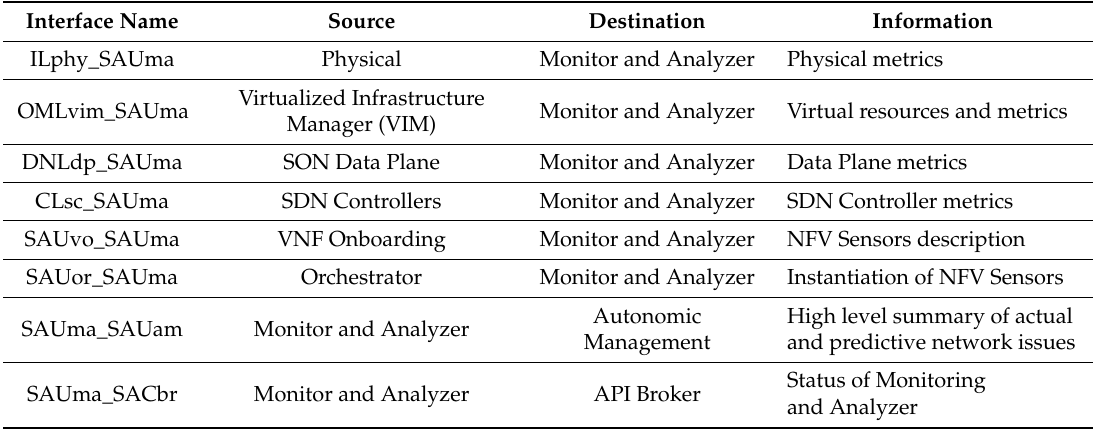
Table 2. Monitor and Analyzer